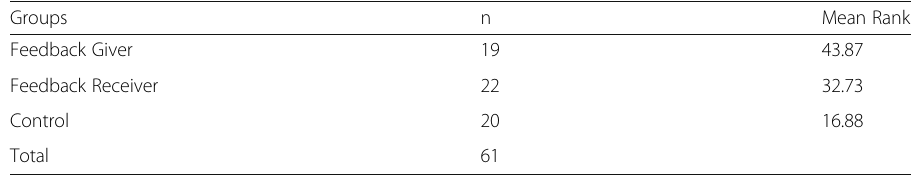
Table 6 Kruskal-Wallis H Test for the picture description task Groups